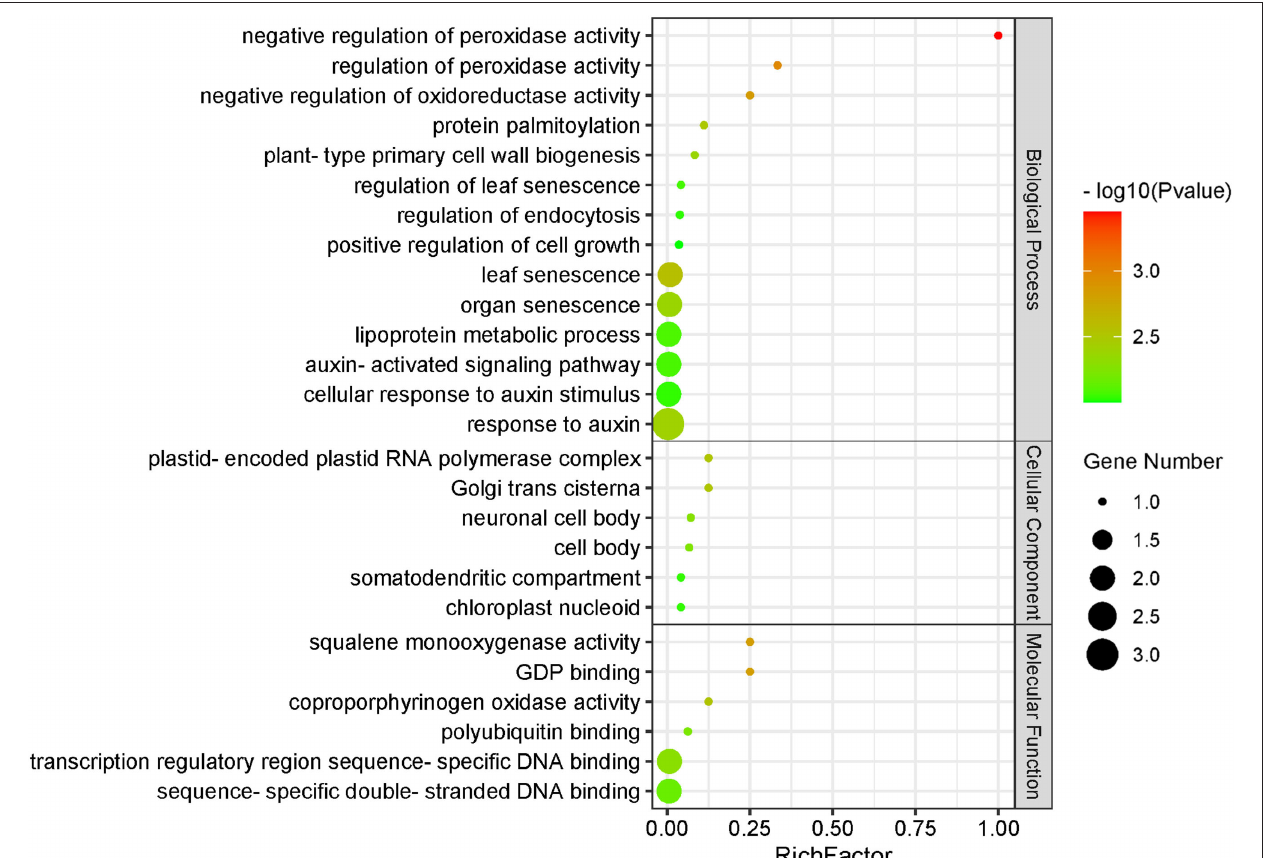
FIGURE 5 | Functional enrichment analysis of protein–protein interaction networks encoded by 14 candidate genes. P < 0.01.